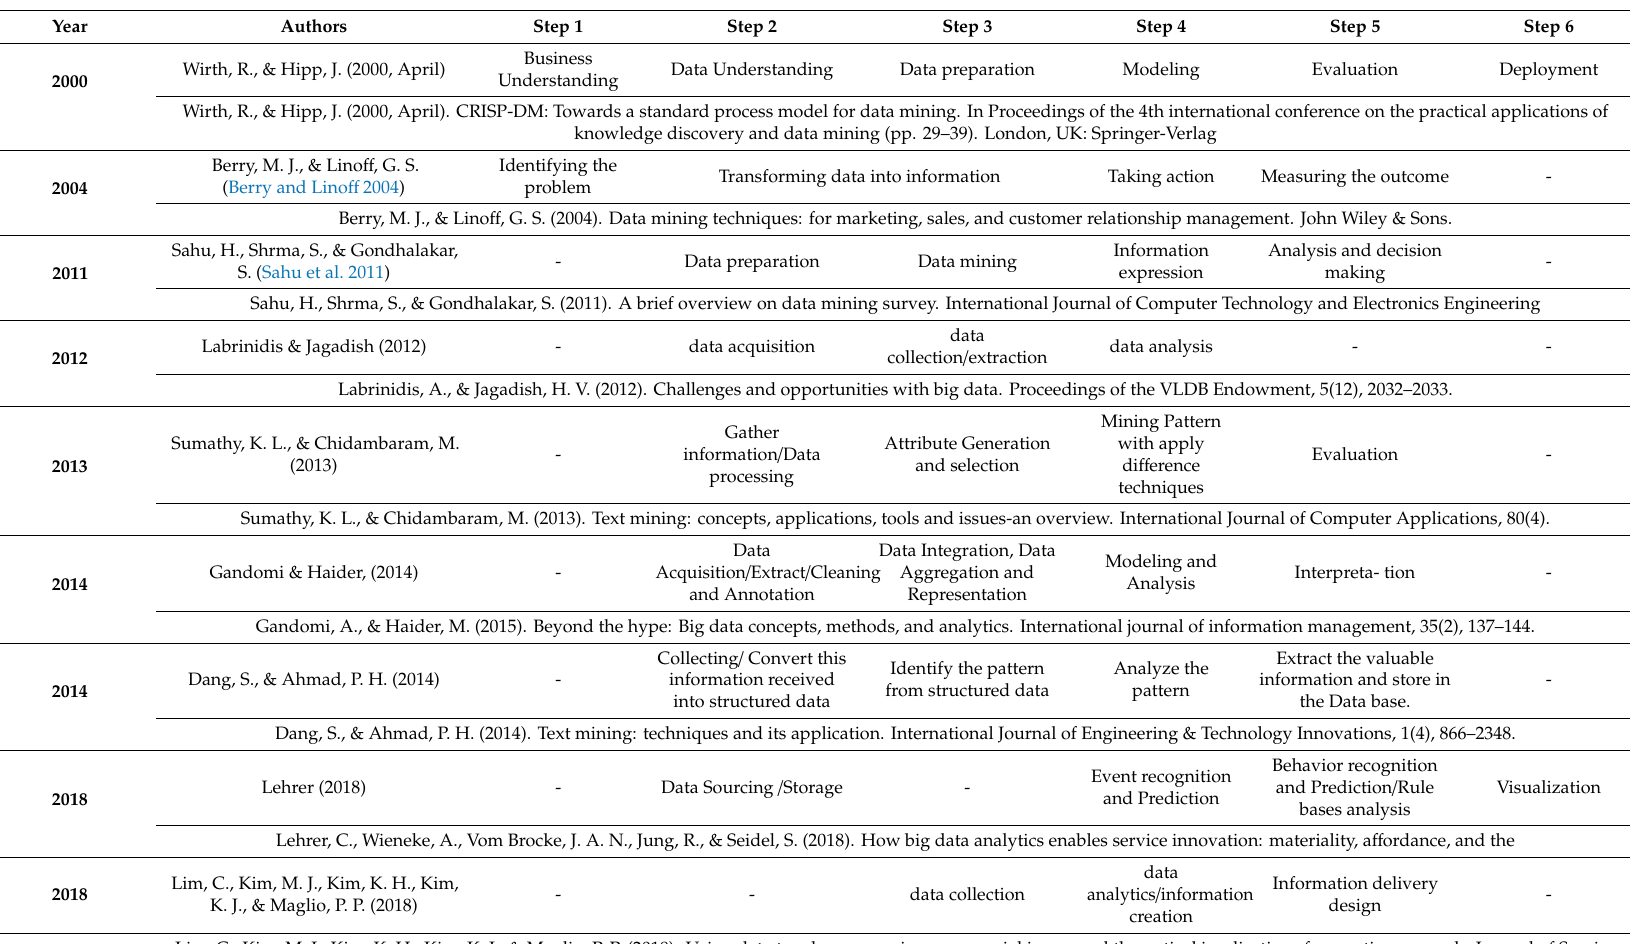
Table 1. Big-data analytics process for service innovation